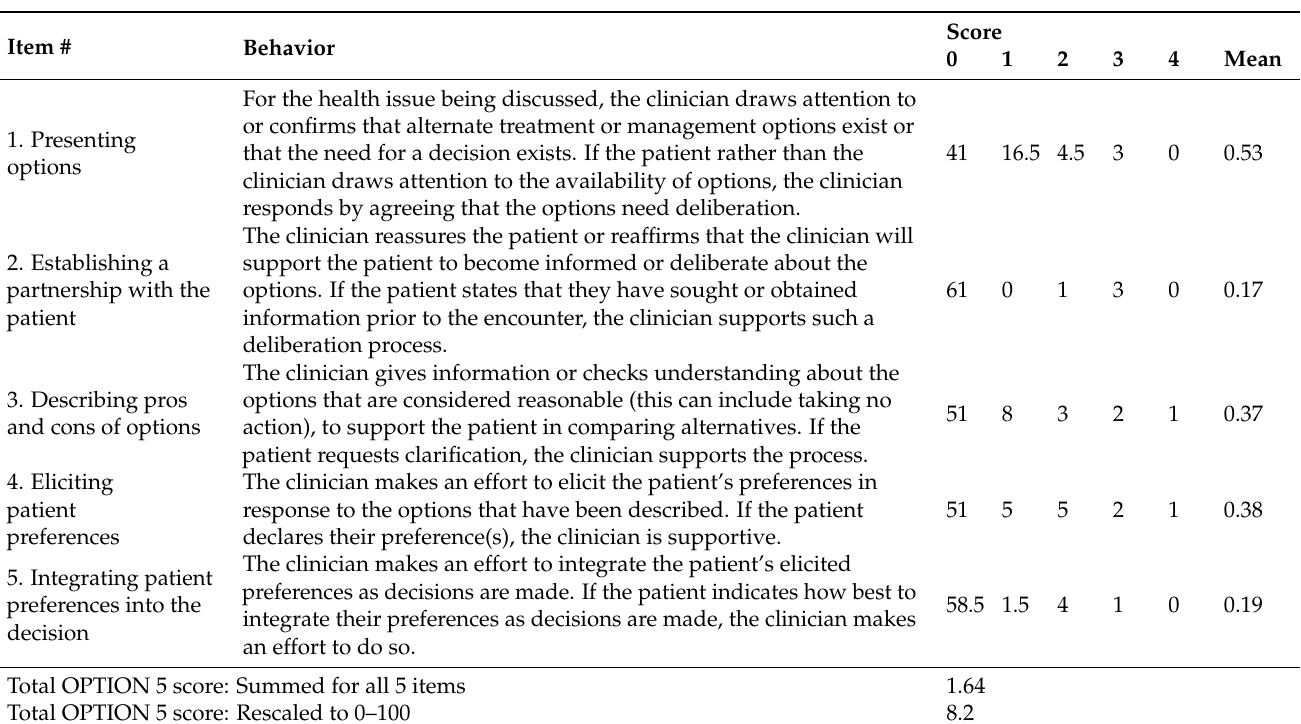
Table 4. The scores for each OPTION 5 item.